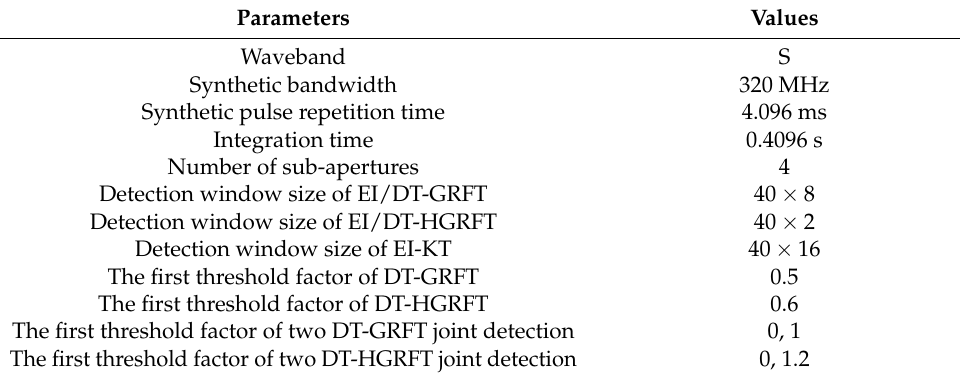
Figure 16. Schematic depiction of the real data scenario. Table 4. Experimental Parameters and Processing Parameters of Real Data.